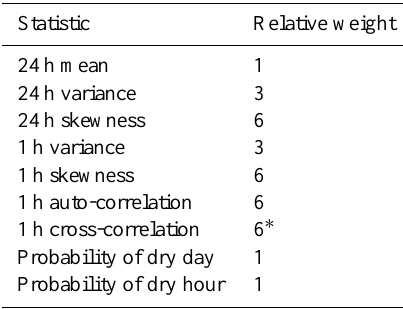
Table 3. The relative weights used in the fitting